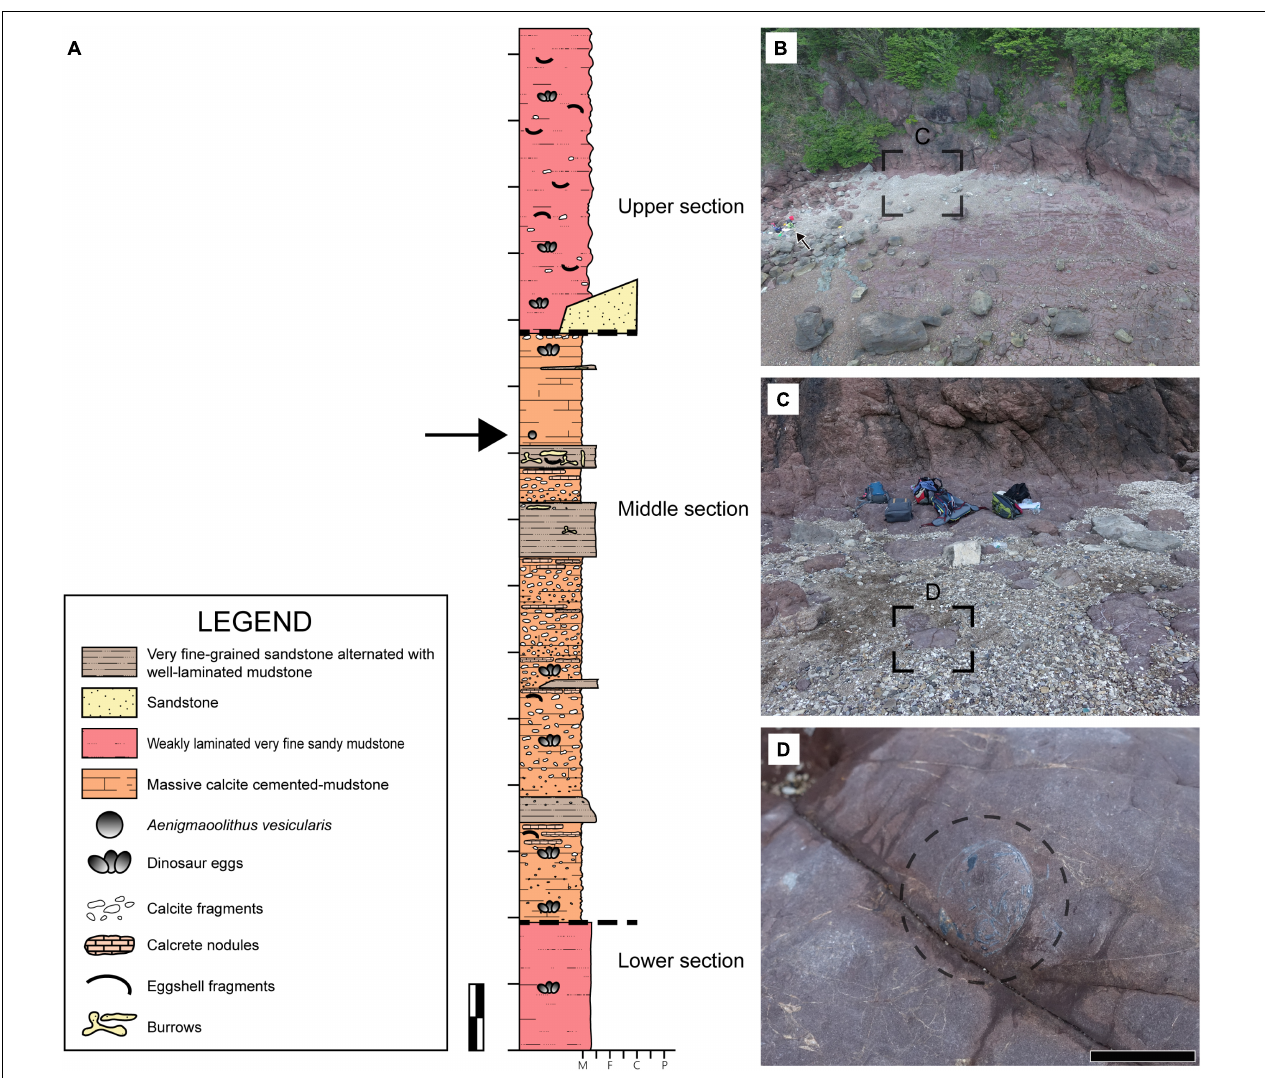
FIGURE 2 | Fossil locality. (A) A columnar section of the study area. It can be roughly divided into three sections based on the lithological and sedimentary characteristics. The lower and upper sections are composed of weakly laminated very fine sandy mudstones. The middle section is dominated by massive calcite cemented-mudstones and very fine-grained sandstone alternated with well-laminated mudstone. The deposits between the middle and the upper section are coarse to fine sandstones intercalated with mudstones, interpreted to have been deposited in crevasse splay. The stratigraphic position of the studying material is marked by a black arrow. M, F, C, and P stand for mud, fine sand, coarse sand, and pebble, respectively. (B) An aerial view of fossil locality. The material of this study was found near the upper end of horizontal outcrop. A green backpack for scale (a black arrow). (C,D) The material was found in an exposed siltstone. Scale bars equal 1 m (A) ; 2 cm (D)